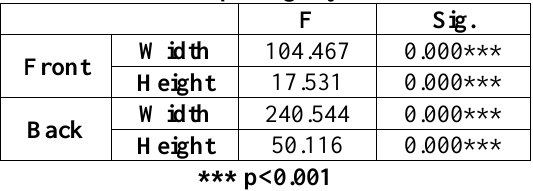
Table 5: Statistical difference between each two brands for height and width of the molar tube front and back openings by LSD test.